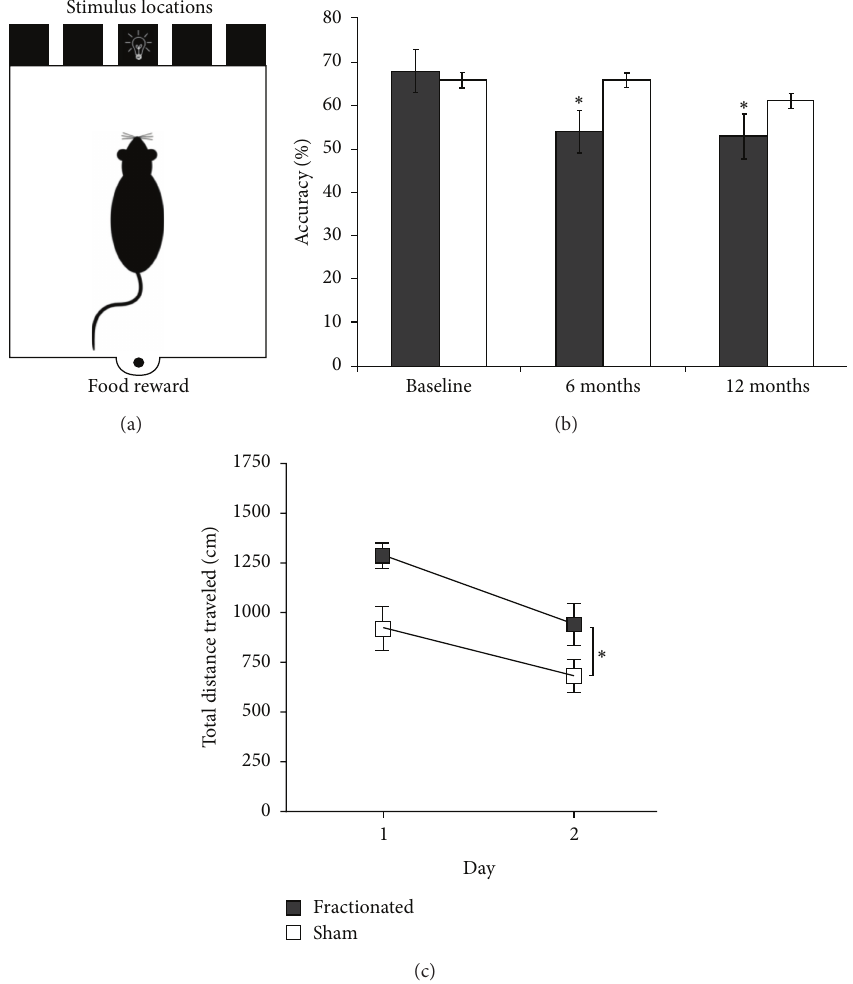
Figure 3: Data from our group showing RT-induced cognitive deficits. (a) Schematic illustration of the 5-CSRTT apparatus. (b) Fractionated X-ray radiation (4Gy/d for 5 days) restricted to the frontal cortex of young rats significantly reduced choice accuracy on a 5-CSRTT 6 and 9 months following RT ( ∗ 𝑃 < 0.05 ). (c) Fractionated WBI in young rats impaired pliancy on a hippocampus-dependent strategy-switching task in the Morris water maze [33] 3-4 weeks following RT ( ∗ 𝑃 < 0.05